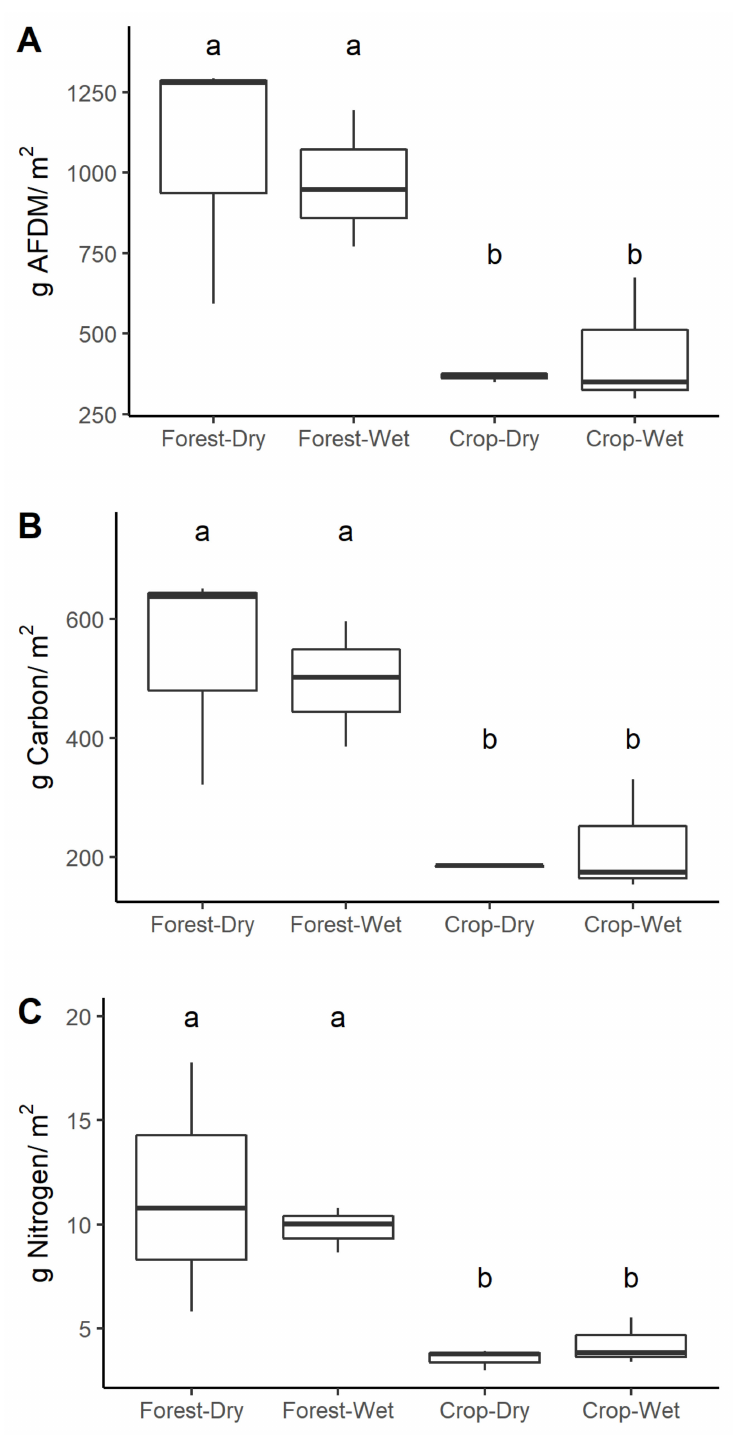
Figure 4. Seasonal and land use differences in the ( A ) areal biomass, ( B ) carbon, and ( C ) nitrogen of coarse benthic organic matter (OM) in forested (grey, n = 3) and cropland (black, n = 3) streams. Distinct letters above boxes in each plot indicate significant differences at p < 0.05. Format of boxplots is as follows: horizontal line indicates the median value, box shows the inter-quartile range, and whiskers extend to 1.5 times the inter-quartile